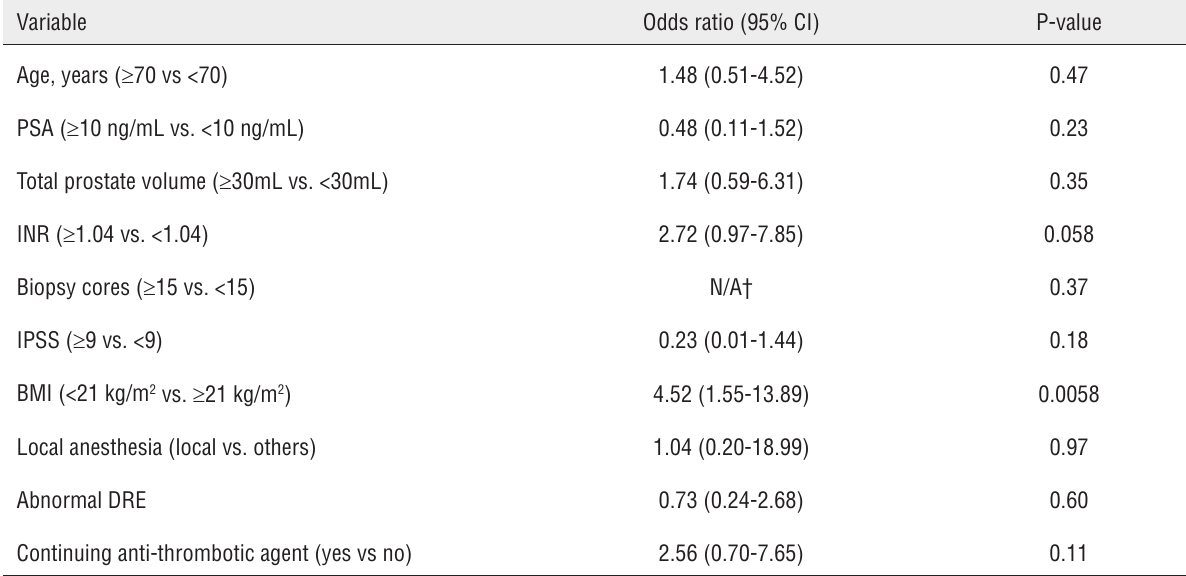
Table 5 - Univariate logistic regression analysis for predicting the risk of hemorrhagic complications.